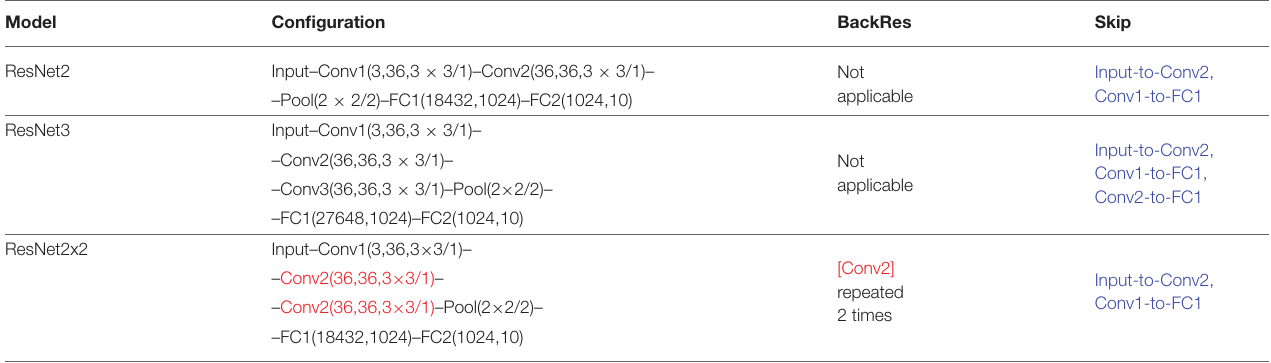
TABLE 7 | CIFAR10 network topologies for STDP training methodology.